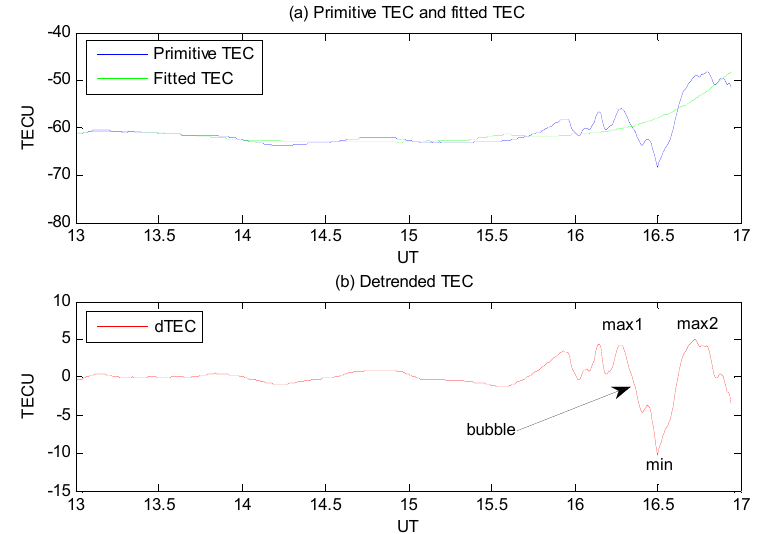
Figure 2. An example of a plasma bubble detected by station HKKT and satellite PRN 23 on January 25, 2014. ( a ) Primitive total electron content (TEC) time series (blue line) and fitted TEC time series using Savitzky–Golay smoothing filter (green line); ( b ) detrended TEC time series obtained by subtracting between the primitive and fitted TEC time series (red line). The annotation “min” represents TEC depletion (minimum) and the annotations “max1” and “max2” represent the adjacent two maximums.